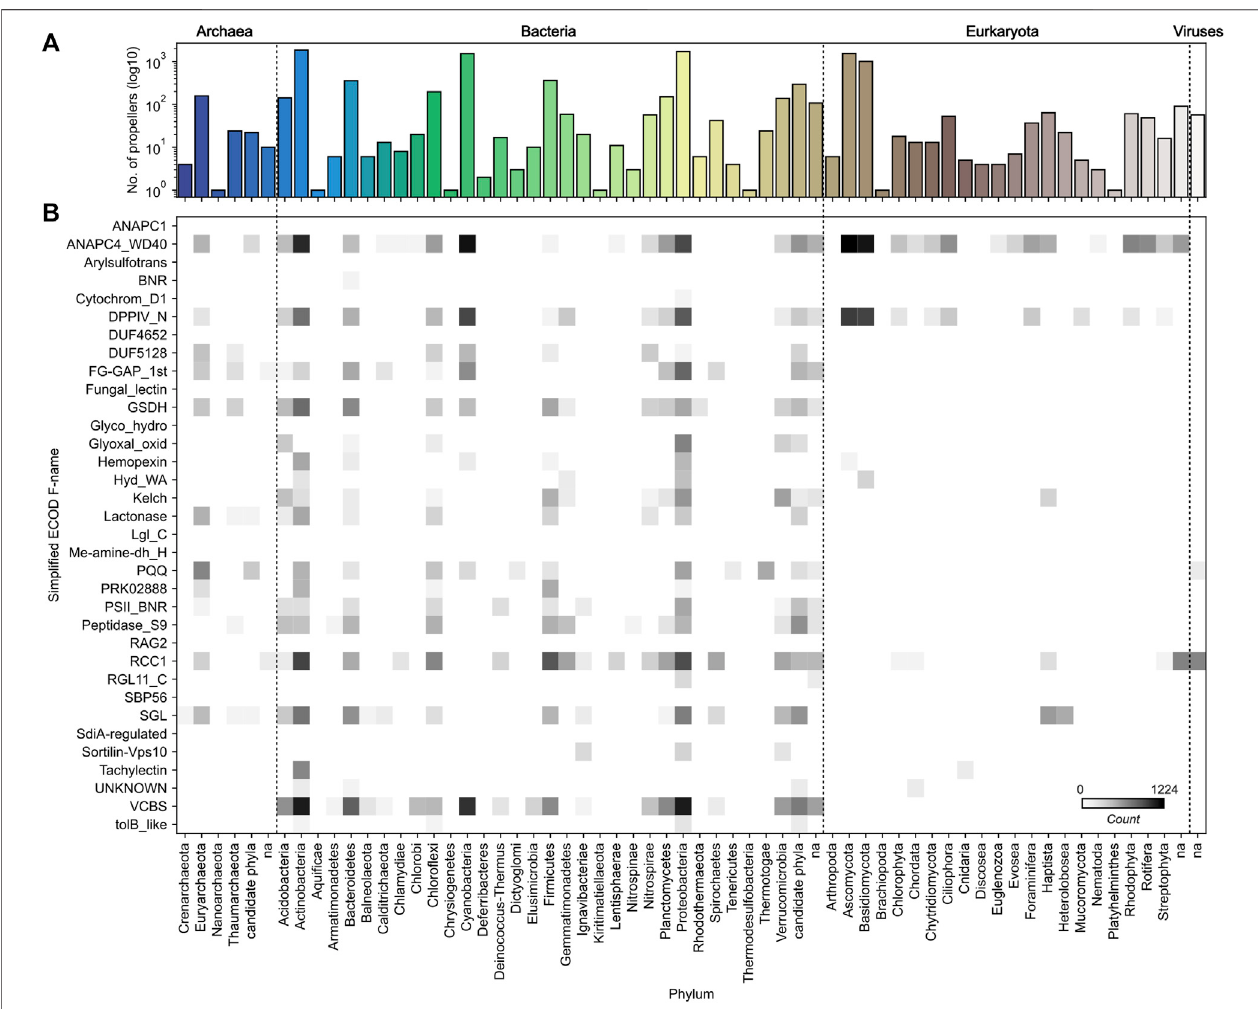
FIGURE 3 | Taxonomic distribution of highly repetitive β -propeller sequences. (A) The frequency, in logarithmic scale, of highly repetitive β -propeller sequences from different phyla in the collected dataset. (B) Heatmap of the frequency of highly repetitive β -propeller sequences of different ECOD families in different phyla. Colors are in logarithmic scale.